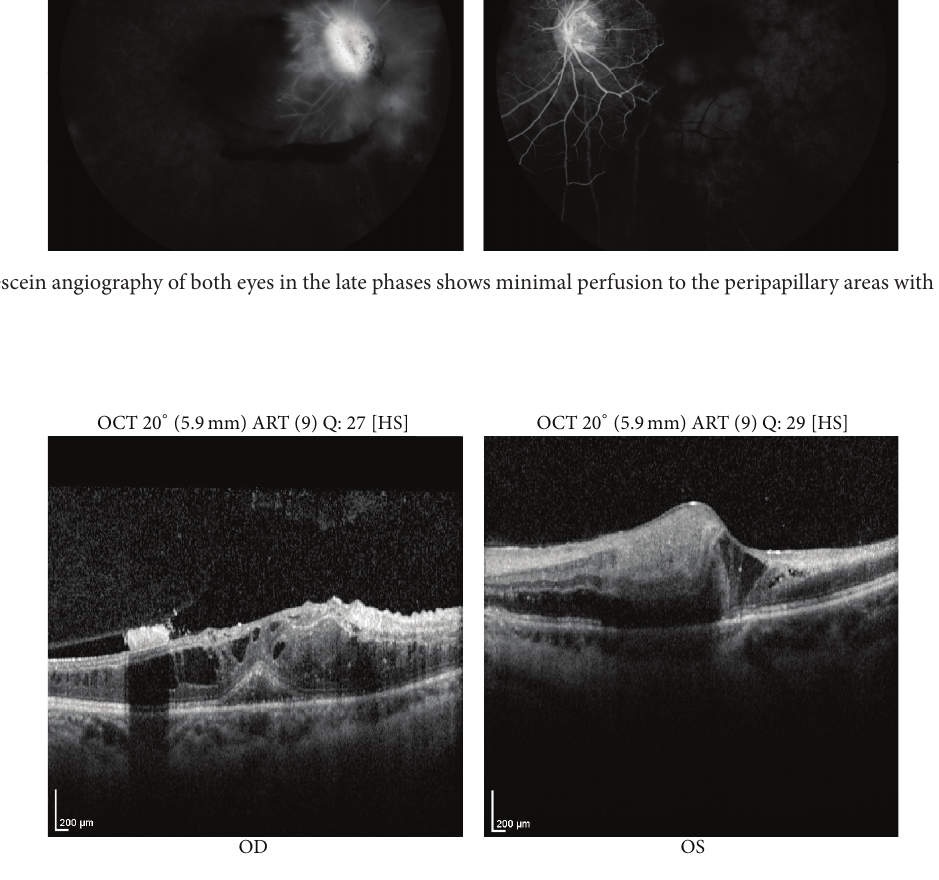
Figure 3: Optical coherence tomography of maculae shows cystoid macular edema and loss of foveal